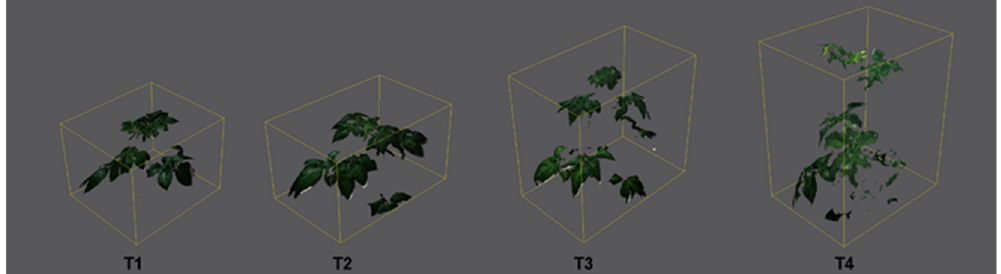
Figure 7. Color images of 3D plant models of potato plants scanned by PlantEye F500 grown for ten days in four different temperature treatments: 20/15 °C (T1), 25/20 °C (T2), 30/25 °C (T3), and 35/30 °C (T4).